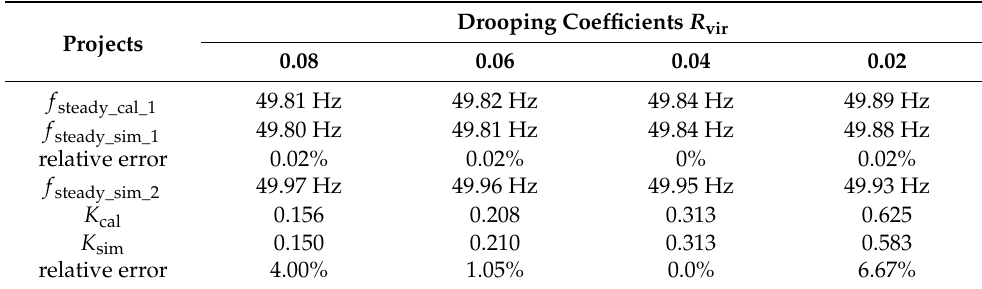
Table 4. Calculated and simulation results under different control modes (load